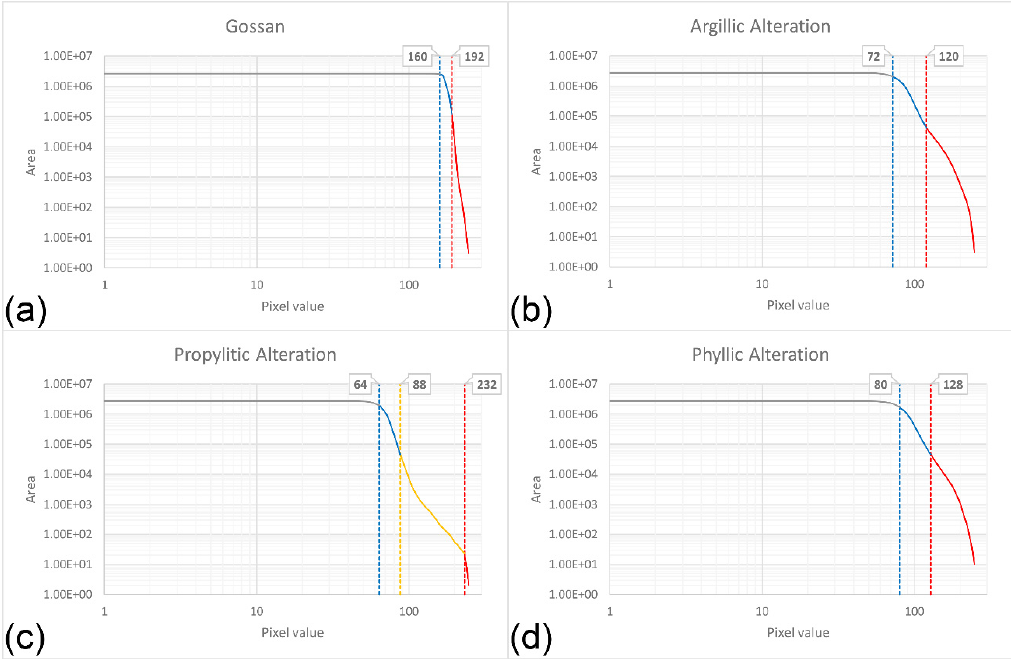
Figure 10. Logarithmic scaled plots of area versus pixel values for the selected MNF components for enhancing the ( a ) gossans, ( b ) argillic, ( c ) propylitic, and ( d ) phyllic alteration zones.